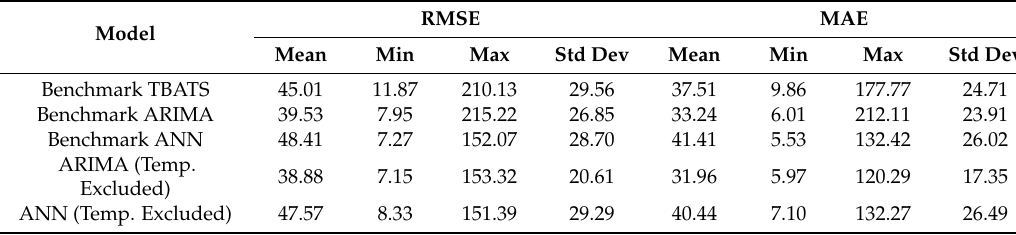
Table 6. Error Values and variables excluded for TBATS, ARIMA, ANN.